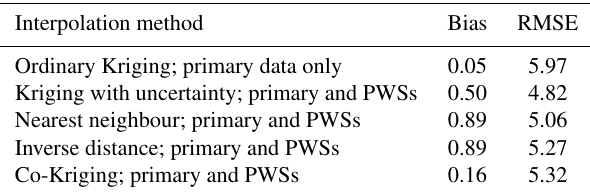
Table 7. Bias and RMSE (in millimetres) for all stations and events for different interpolation methods for 1h